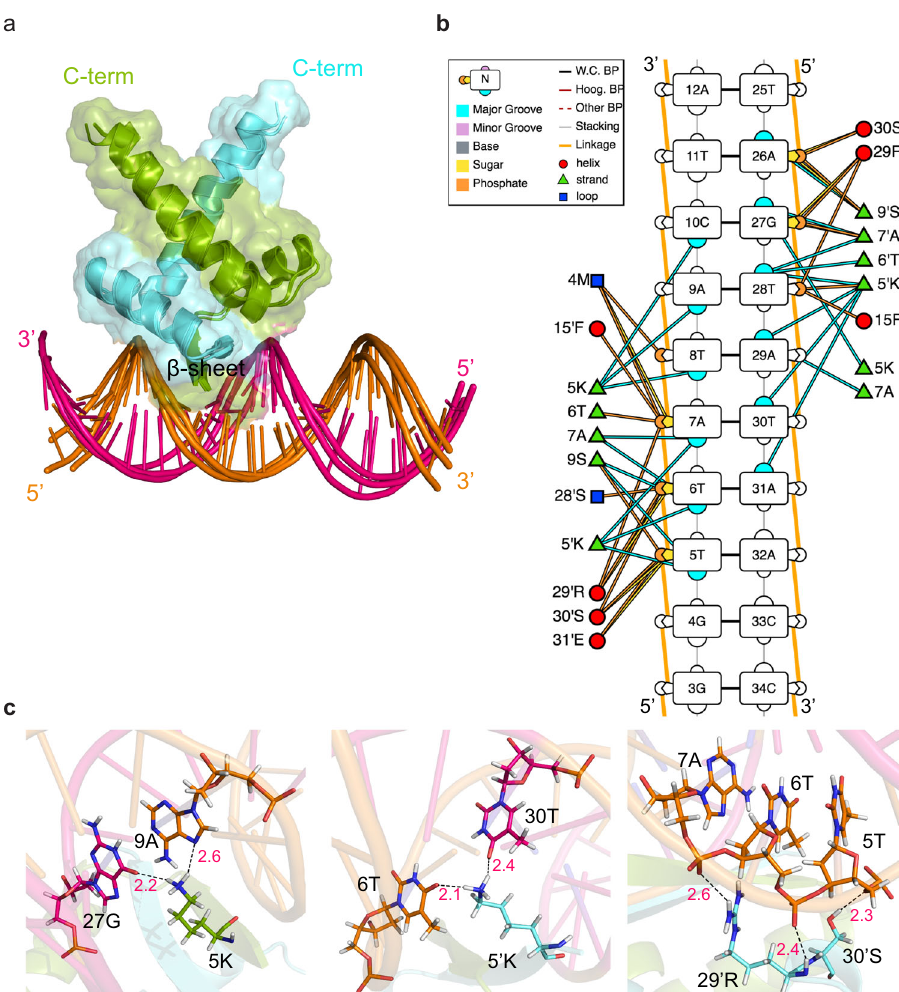
Fig. 7 HADDOCK model of nMazE6-cognate operator DNA complex. a Cartoon representation of the ensemble of the top three HADDOCK structures with the lowest interaction energies and lowest restraints violations. b Diagrammatic illustration of protein-DNA interactions. The sequence of the operator DNA is labeled in 5 ′ – 3 ′ directionality. Plausible interactions of protein residues with sugar, phosphate and major groove are represented by yellow, orange and blue colored solid lines. c Speci fi c recognition of bases by residues in β -sheet and electrostatic interaction of residues from α 2 helix with sugar- phosphate backbone of TATACT -10 motif in operator region. See text for